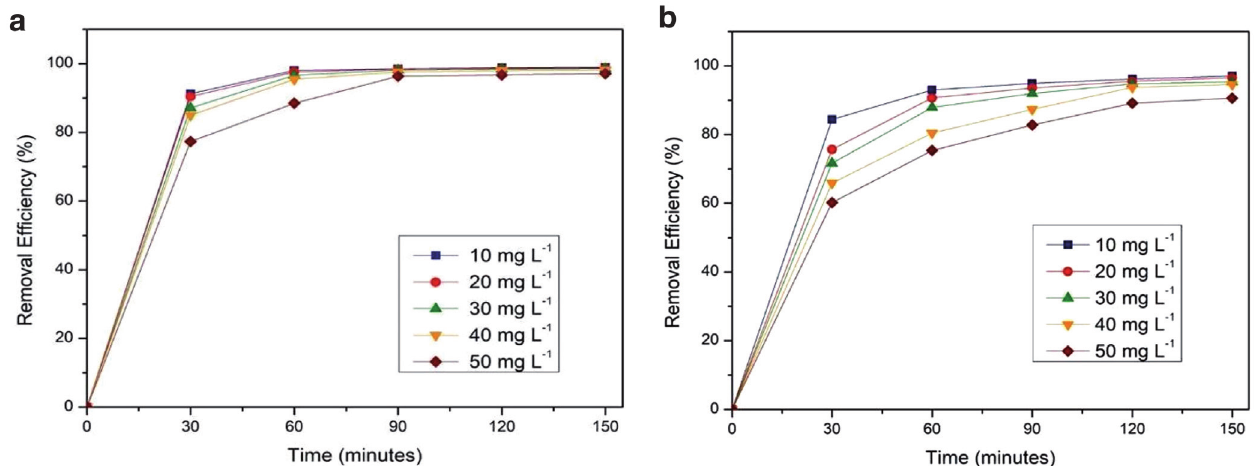
Figure 7. The effect of contact time on the removal efficiency of ( a ) crystal violet and ( b ) methylene blue.